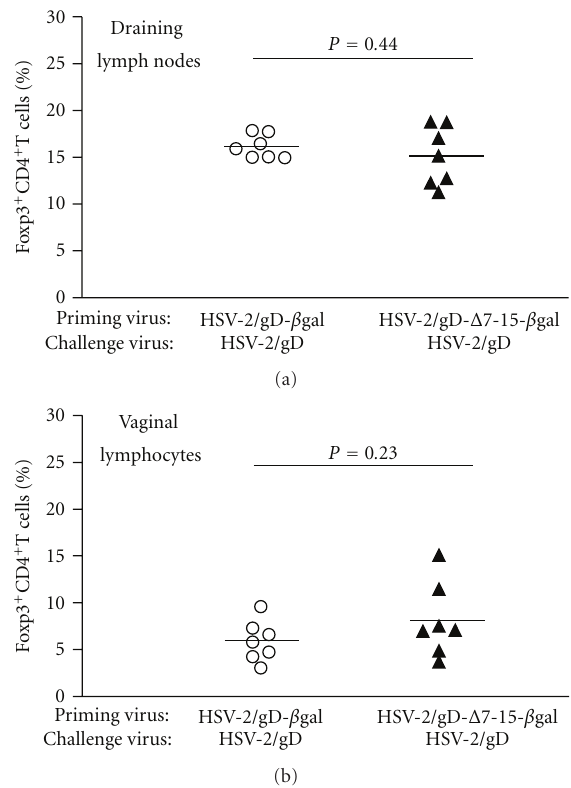
Figure 5: Foxp3 + CD4 + T cell frequencies do not significantly di ff er in draining lymph nodes (a) or vaginal mucosa (b) among lymphocytes isolated from groups of mice primed with viruses that can (HSV-2/gD- β gal, left, open circles) or cannot (HSV-2/gD- Δ 7-15- β gal, right, filled triangles) engage HVEM. Symbols show data from individual mice, with the horizontal line designating the mean for each experimental group. Data are pooled from three independent experiments with 3-4mice per